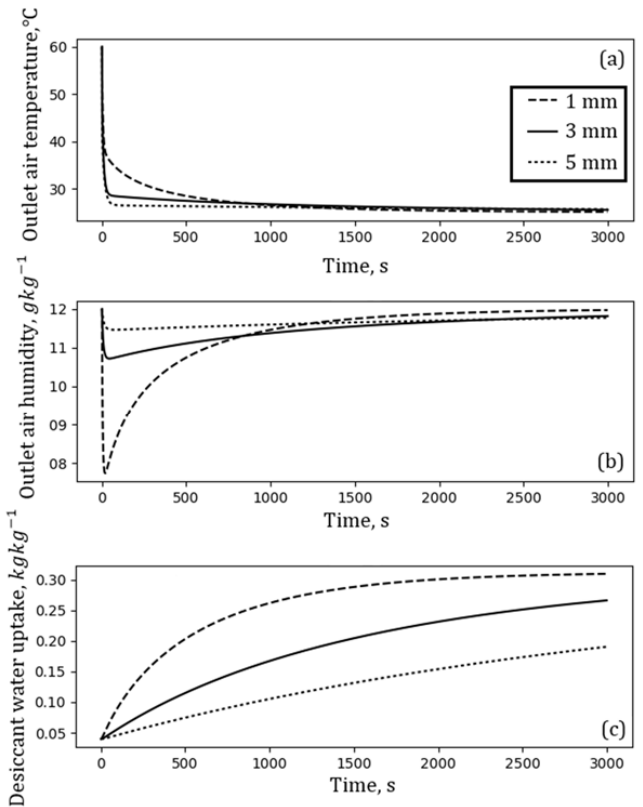
Figure 4. The influence of the desiccant particle diameter on adsorption characteristics: ( a ) Outlet air temperature; ( b ) outlet air humidity; and ( c ) desiccant water uptake.